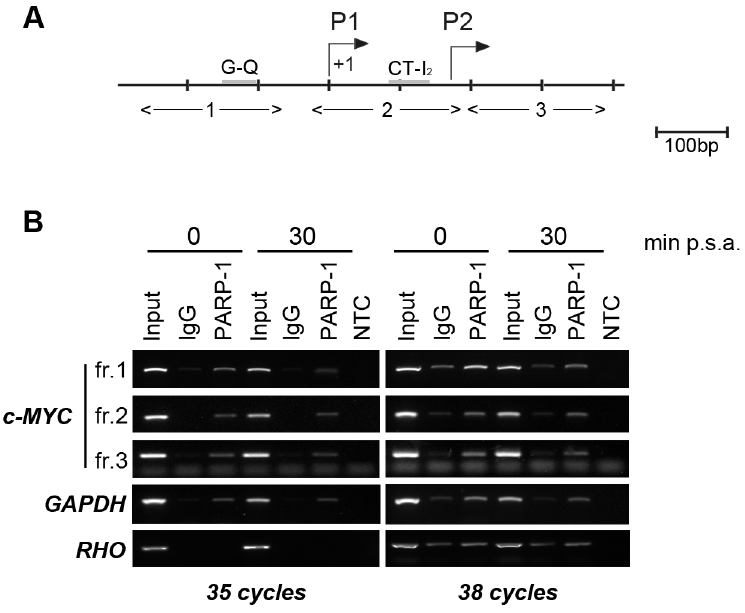
Figure 2. PARP-1 binds invivo to c-MYC promoter. A, Schematic representation of the c-MYC promoter region (adapted from [21]). The transcriptional start sites P1 and P2, the Guanine-quadruplex forming element (G–Q), the consensus sequence CCCTCCCC (CT-I 2 ) are shown. The fragments analyzed in B are indicated below the scheme. B, ChIP analysis of PARP-1 binding to c-MYC promoter. The assays were carried out in quiescent (0) and in 30 minutes serum-stimulated cells, using an antibody specific for PARP-1 or a normal rabbit IgG as a negative control of the immuno-precipitation. Diluted Input and immuno-precipitated samples were subjected to PCR amplification of the indicated fragments of c-MYC (fr.1, fr.2 and fr.3) or GAPDH promoter regions. RHO promoter was used as a negative control of PARP-1 binding. Numbers above the panels indicate the minutes post serum addition (min p.s.a.). Numbers below the panels indicate the cycles of PCR amplification. The results shown are representative of multiple independent experiments.